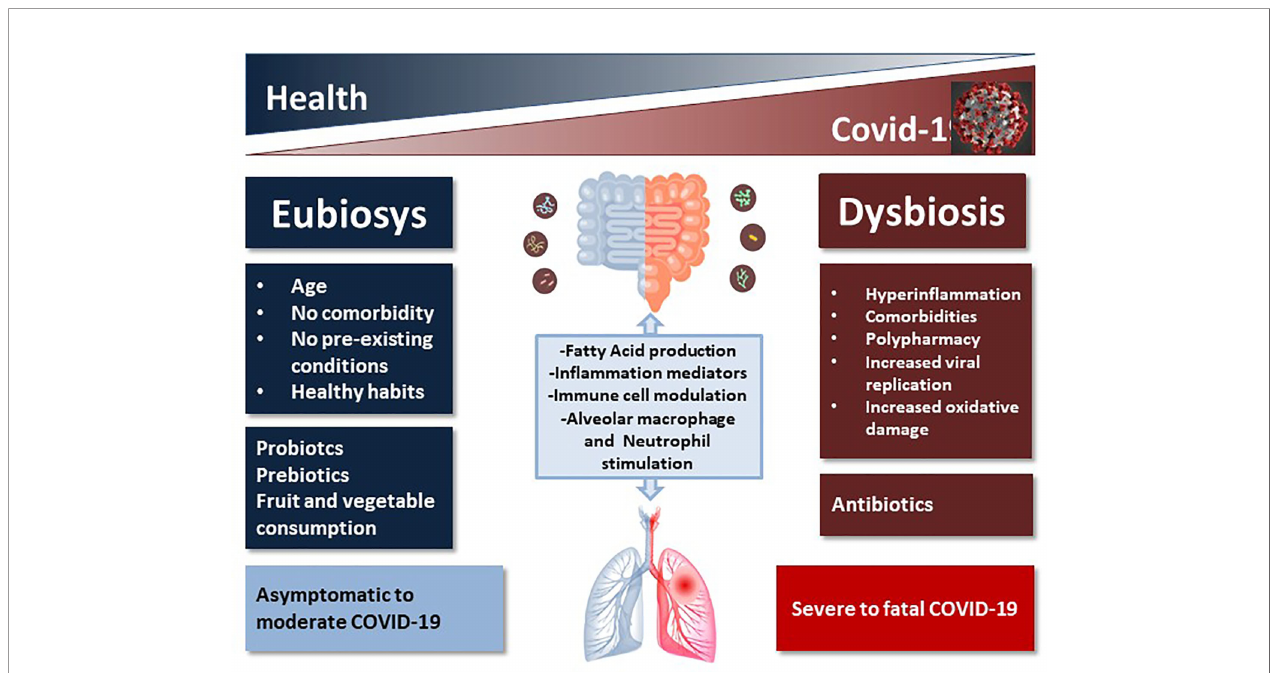
FIGURE 1 | Schematic representation of the impact of healthy vs. unhealthy microbiota on COVID-19 outcome. The complex intercommunication through the gut- lung axis might be important in predetermining the susceptibility of airways to SARS-CoV-2 infection and COVID-19 clinical outcome as a function of the inter- individual variations in microbiota composition and